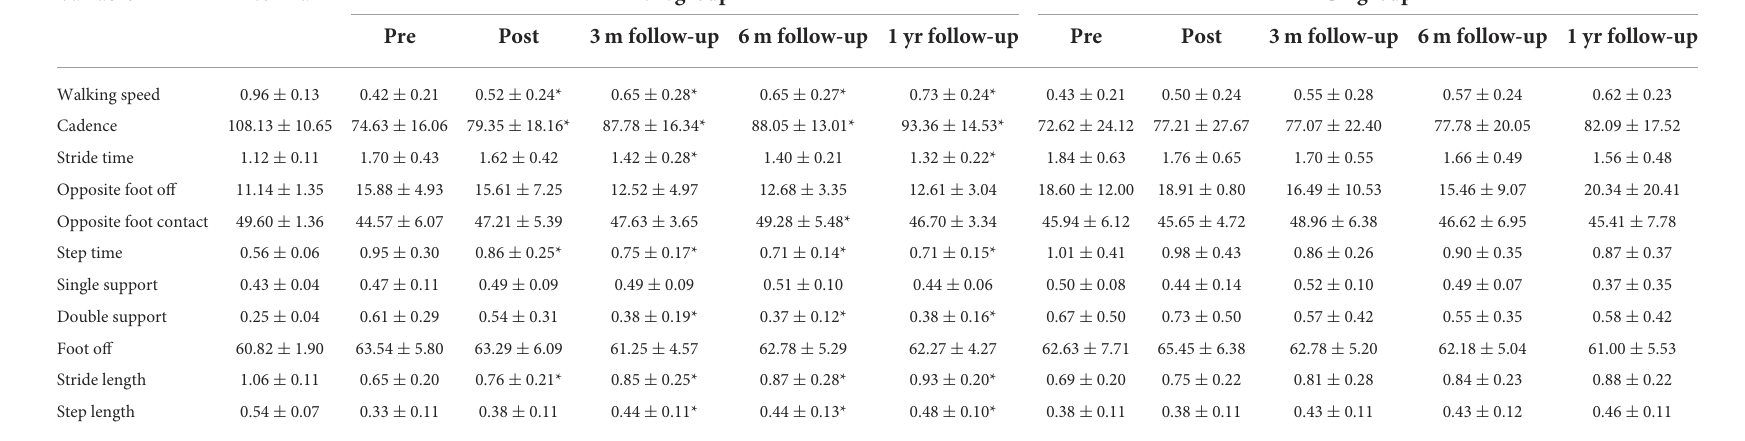
TABLE 4 Spatiotemporal results of pre, post and follow-up among three groups.